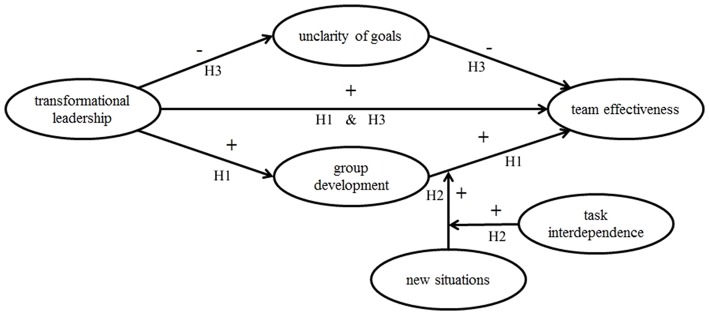
Model 1, representing the hypotheses H1, H2, and H3.